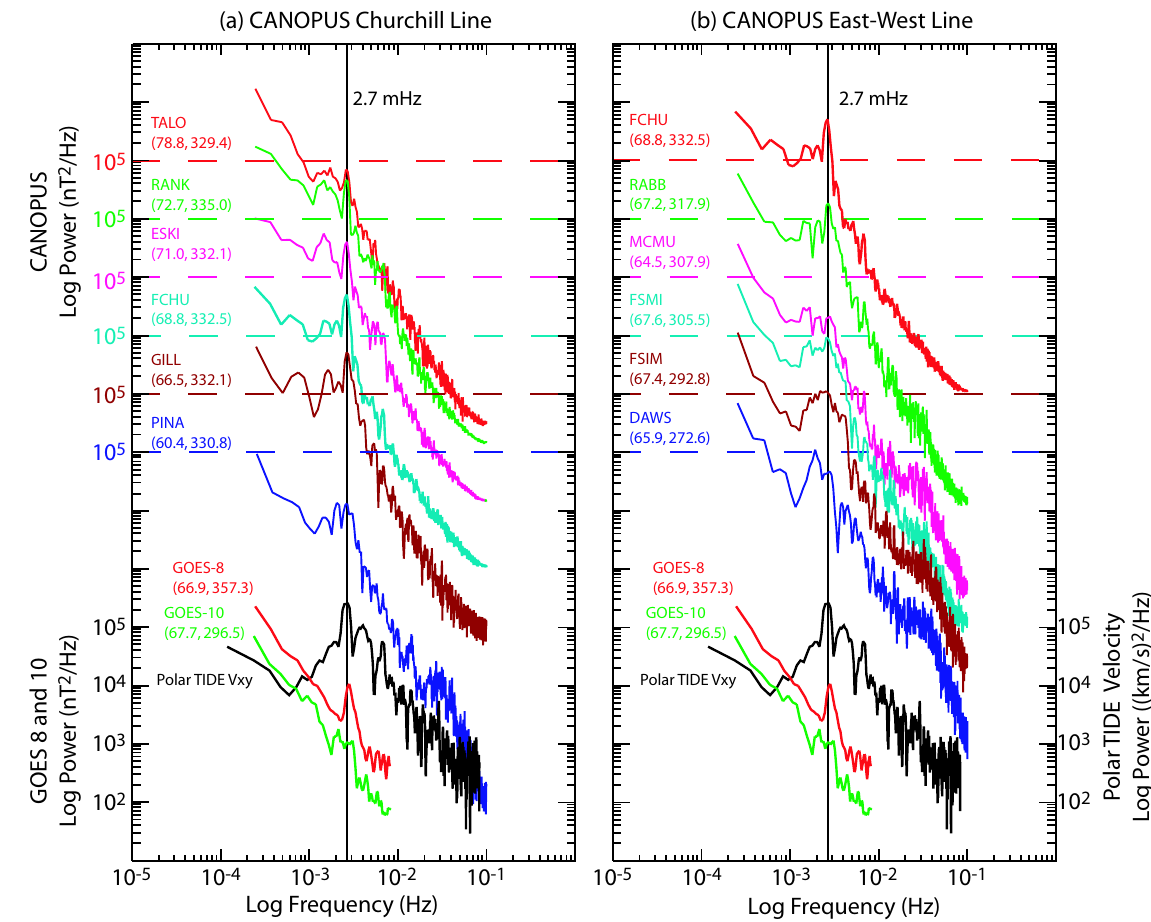
Fig. 11. Stack plots of power spectra for the CANOPUS magnetic field, GOES 8 and 10 magnetic field, and the Polar TIDE ion velocity moment ( V xy ). Note the power spectra of the CANOPUS stations have different baselines as indicated by the color-coded dashed lines. (a) Stations along the Churchill line. (b) Stations along the east-west